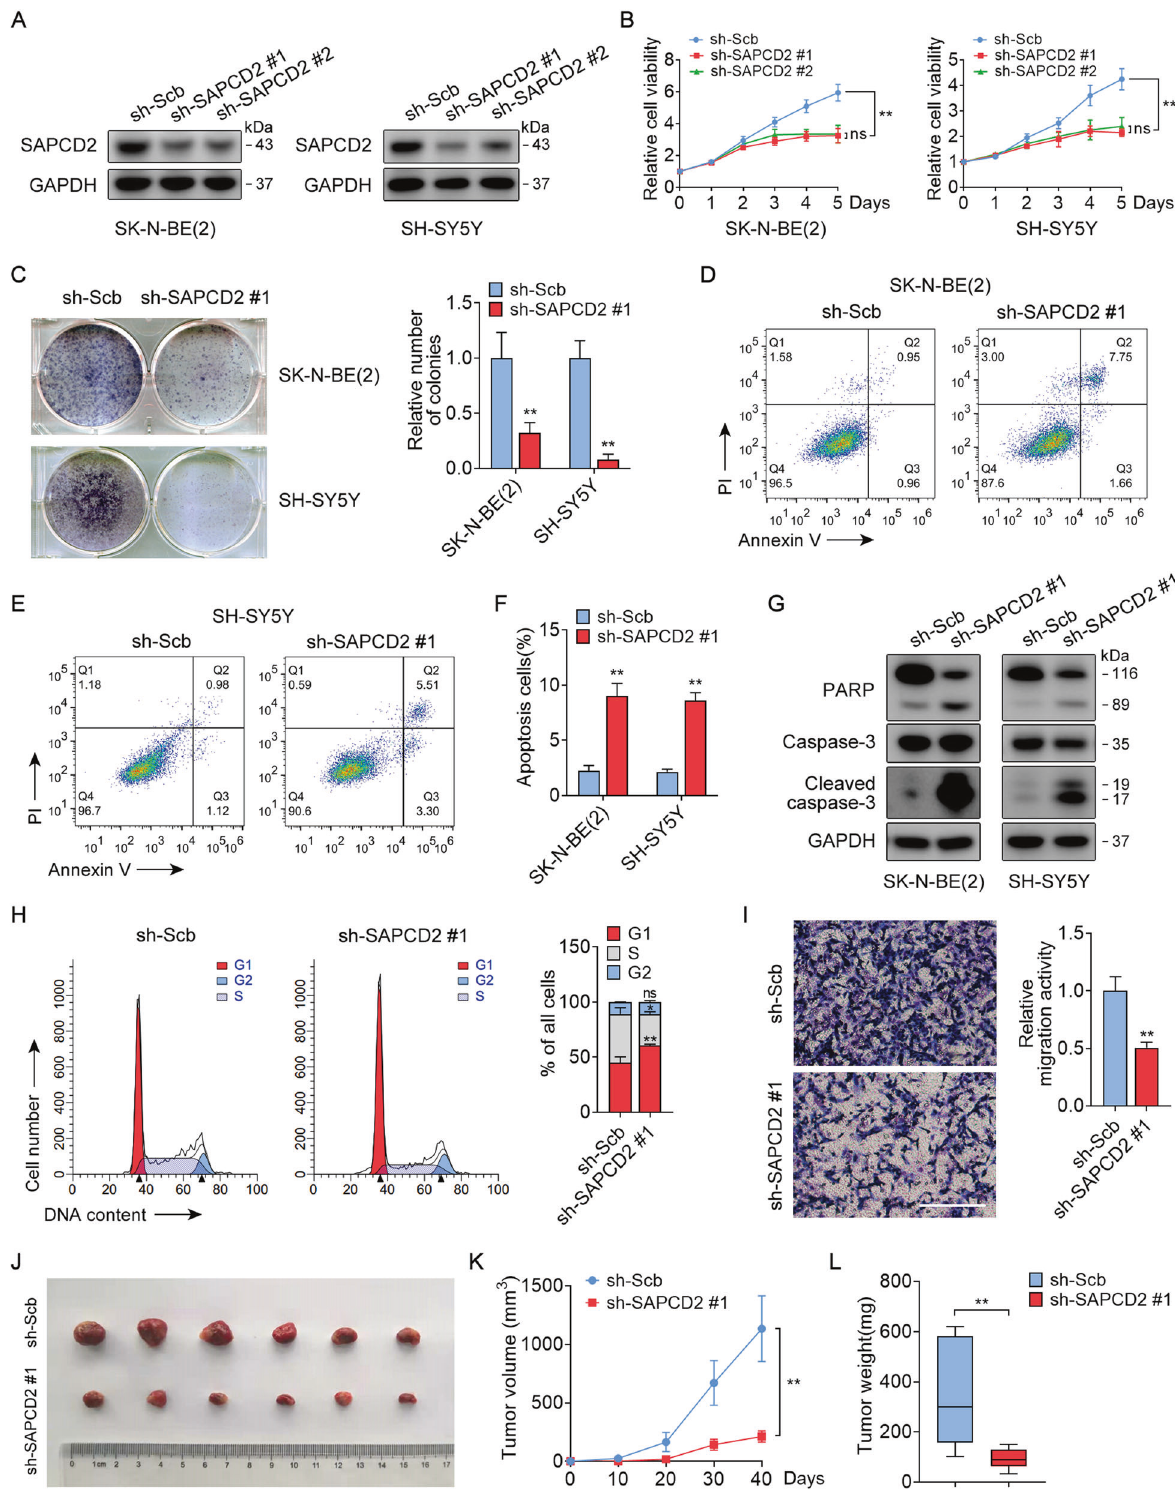
division, and regulation of the mitotic cell cycle (Fig. 3C). In addition, Gene Set Enrichment Analysis (GSEA) revealed that the downregulated genes in SAPCD2-knockdown cells were signi fi cantly enriched in SAPCD2-positively correlated genes in 88 (GSE16476) and 498 specimens (GSE62564), and vice versa (Supplementary Fig.